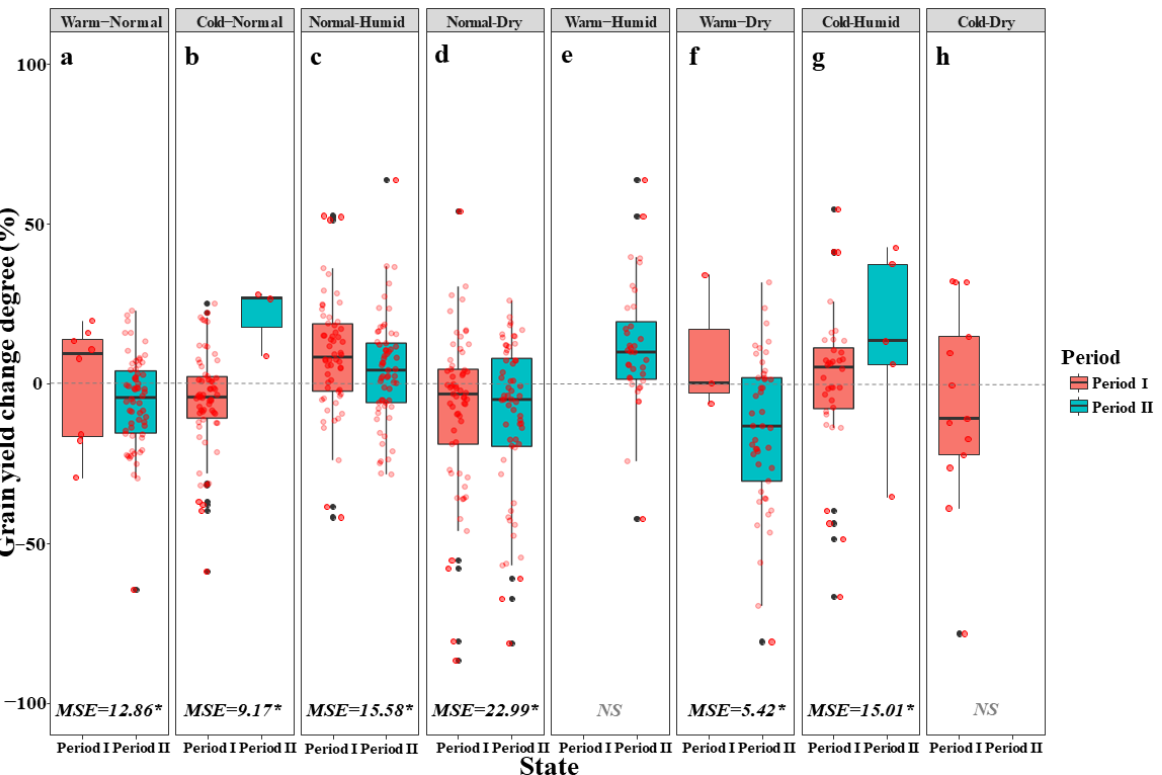
Figure 7. The grain yield change degree under the climate extremes compared with the normal climate and a comparison of the yield change rate in the two time periods (each box represents the impact of the climate extremes on the yield relative to the normal climate during the period). The red dots indicate the yield change rate of the stations corresponding to extreme conditions. (( a ) warm-normal; ( b ) cold-normal ; ( c ) normal-humid; ( d ) normal-dry; ( e )warm-humid; ( f ) warm-dry; ( g ) cold-humid; ( h ) cold-dry). * Significant at p ≤ 0 .05; “NS” denotes no significance levels. Table 3. MSE values of yield changes between climatic extremes and normal climate during peri- ods I and II.